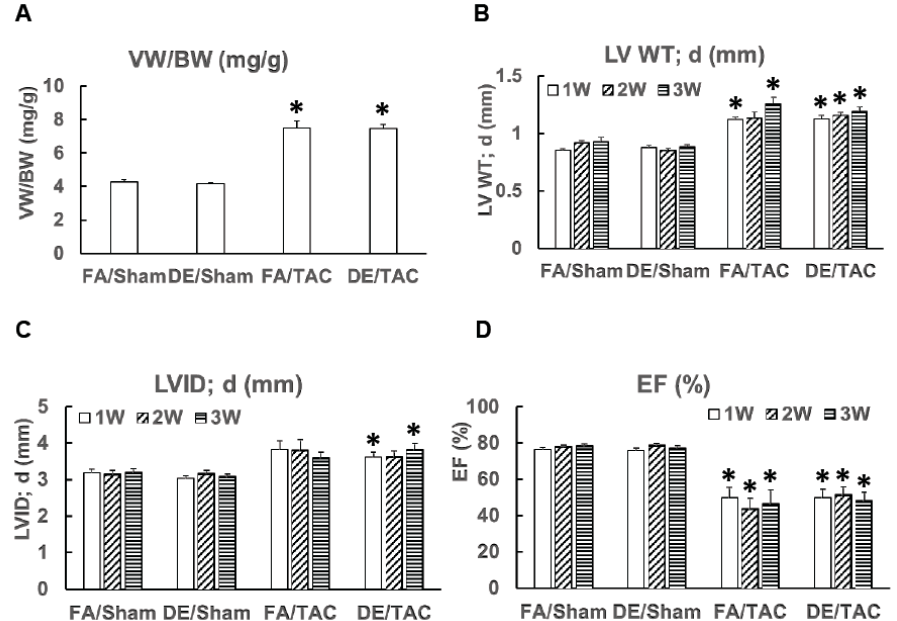
Figure 2. Effects of neonatal diesel particulate exposure and acute pressure overload on cardiac hypertrophy and ventricular function. Neonatal mice were exposed to DE (300 µg/m 3 ) or FA (6 h/day, 5 days/week) from birth until weaning at 21 days and were then maintained in FA. Transverse aortic constriction (27 gauge needle) was done at 12 weeks of age, with serial echocardiography for three weeks post surgery, followed by euthanasia and organ harvest. ( A ) assessment of cardiac hypertrophy by ventricular weight to body weight ratio (VW/BW); ( B ) left ventricular wall thickness (LVWT) measured by echocardiography; ( C ) left ventricular internal dimension at end of diastole (LVID) measured by echocardiography; ( D ) left ventricular ejection fraction (EF) measured by echocardiography. FA/sham: n = 7; FA/TAC: n = 7 ( n = 8 in one week and two weeks echocardiography data; one mouse died two weeks after TAC); DE/sham: n = 12; DE/TAC: n = 12; * p < 0.0125 compared to respective sham group. There is no statistical difference between FA/TAC and DE/TAC.